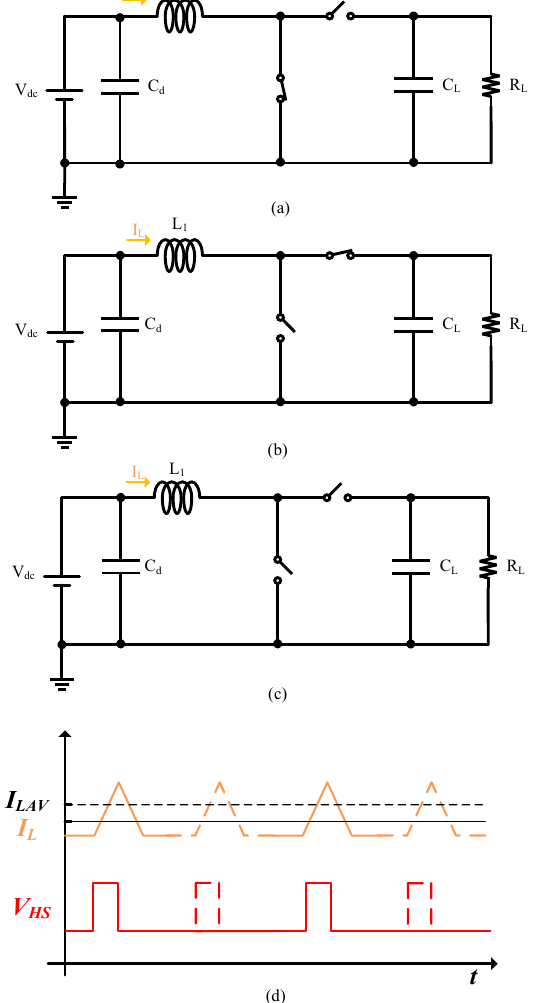
Figure 13. Equivalent circuits of DC-DC boost converter in discontinuous conduction mode (DCM) and its current and voltage waveforms. ( a ) Equivalent circuit when the switch is on and the diode is off. ( b ) Equivalent circuit when the switch is off and the diode is on. ( c ) Equivalent circuit when both the switch and the diode are off. ( d ) Current and voltage waveforms of proposed DC-DC boost